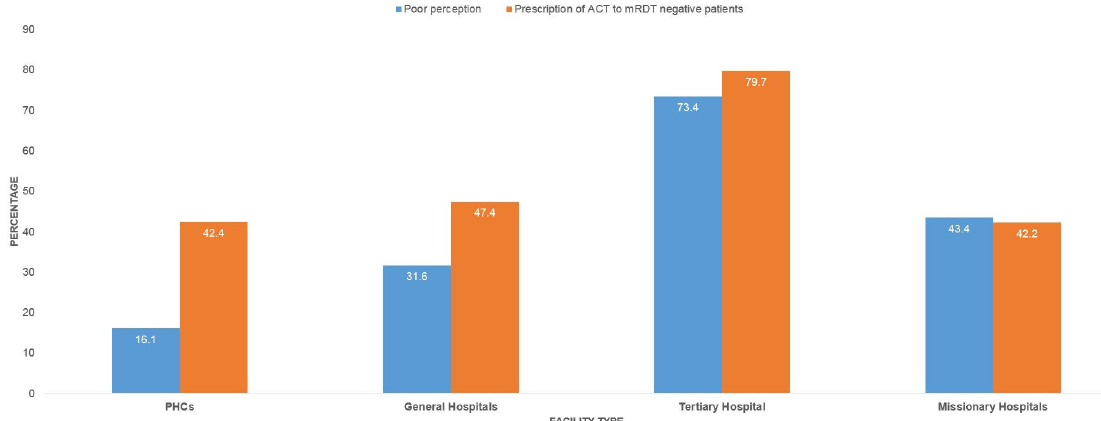
Fig 2. Health workers’ perception of mRDT and prescription of ACTs for patients with negative RDT results, Ebonyi state (N = 303).